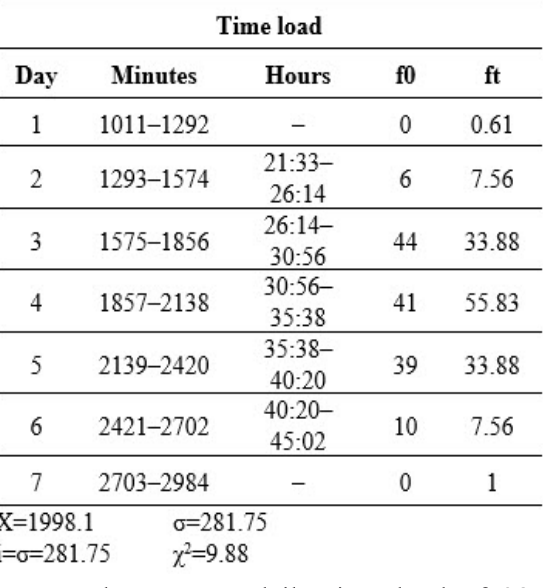
Table 4. Results (X and σ) by the suc - cess